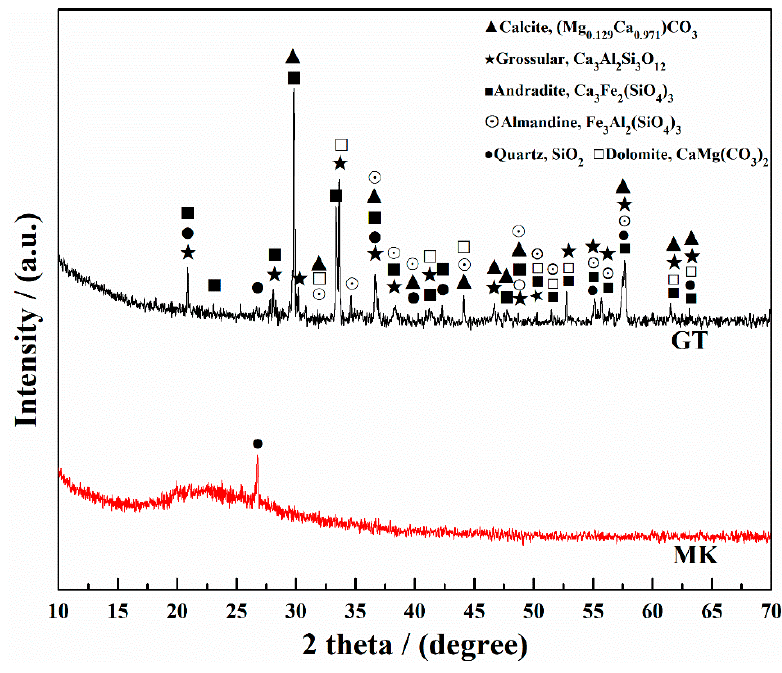
Figure 1. The XRD patterns of the garnet tailing and metakaolin.